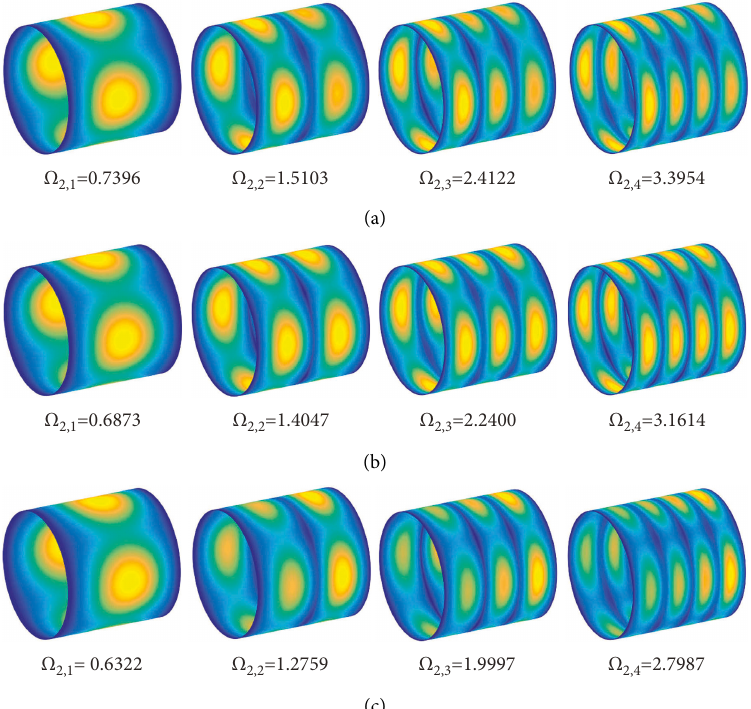
Figure 11: Mode shapes of laminated composite cylindrical shell with variable thickness, (a) α �− 0.5, (b) α � 0, and (c) α �